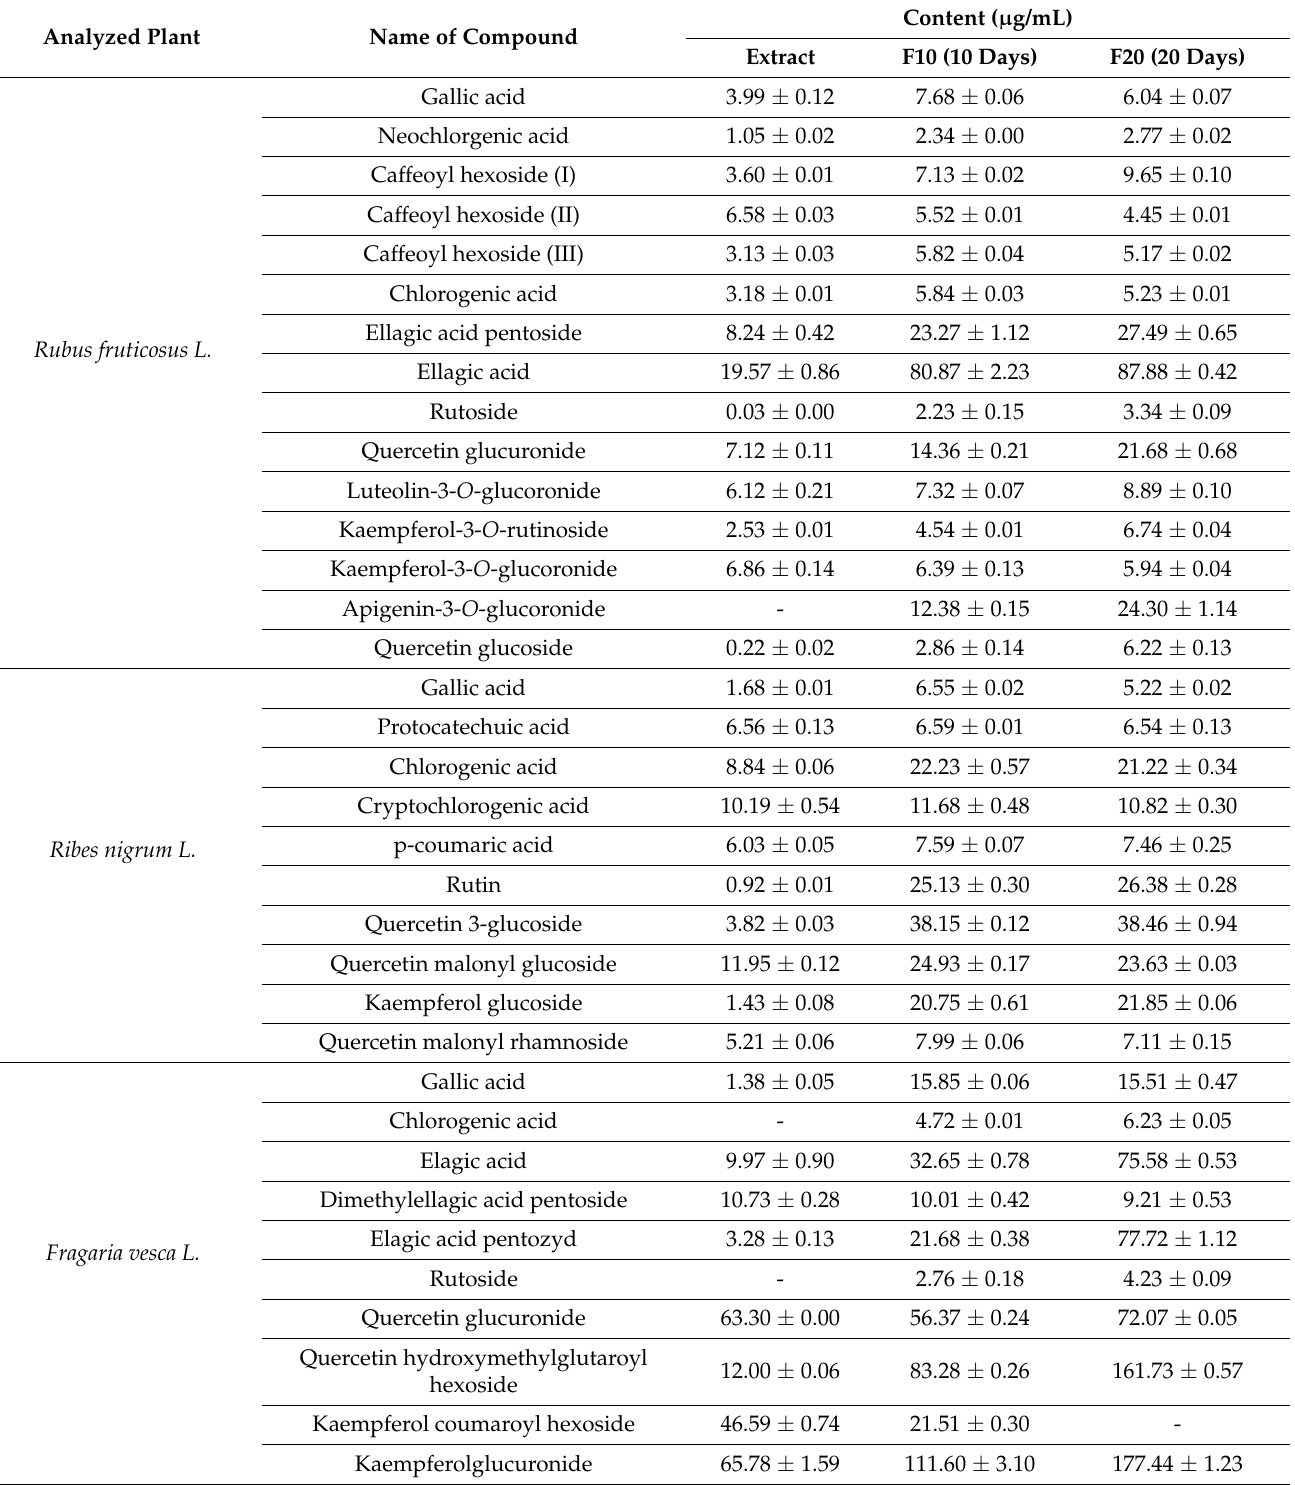
Table 2. UHPLC/DAD/ESI-MS quantitative analysis of R. fruticosus L., R. nigrum L., F. vesca L., V. myrtillus L. water extracts and kombucha ferments. Values are means ± standard deviation (SD) of